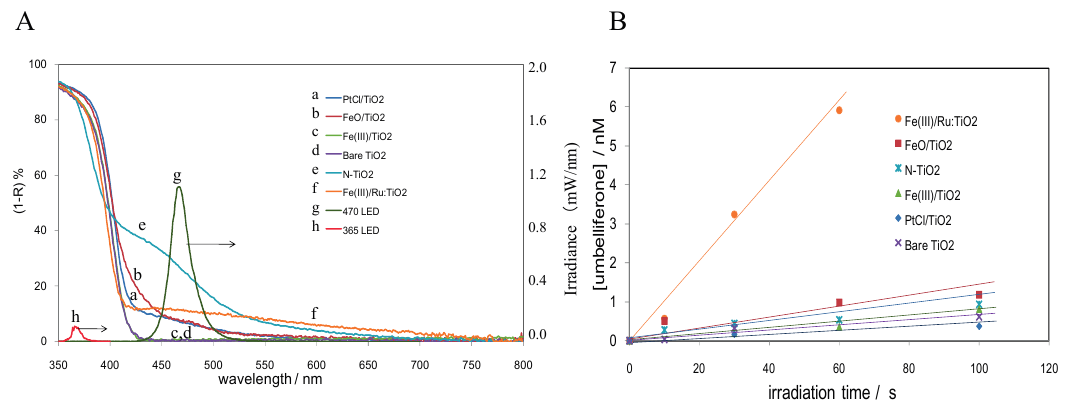
Figure 8. ( A ) Absorption spectra as the complement of the reflectance (1-R) and the irradiance spectra of LED used in the study; ( B ) Concentration of umbelliferone generated under 470-nm irradiation in aqueous coumarin solution was plotted as a function of the irradiation time. Reprinted with permission from [18]. © 2013 American Chemical Society.